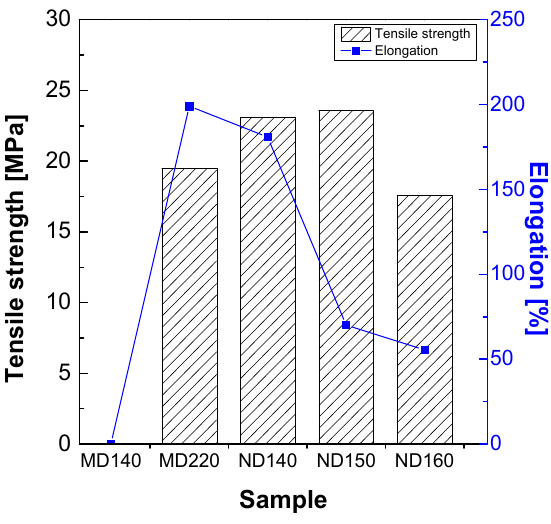
Figure 5. Mechanical property of solidified-state Nafion